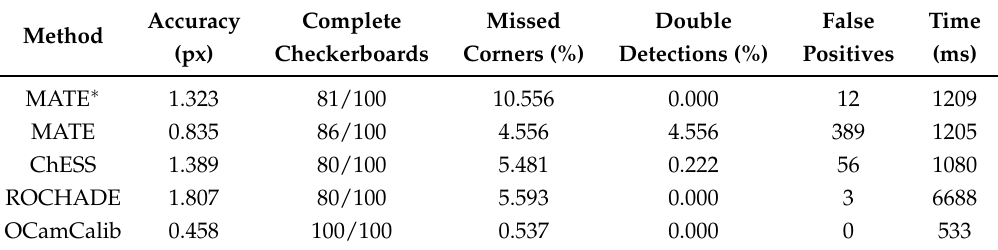
Table 4. Results on the GoPro dataset from